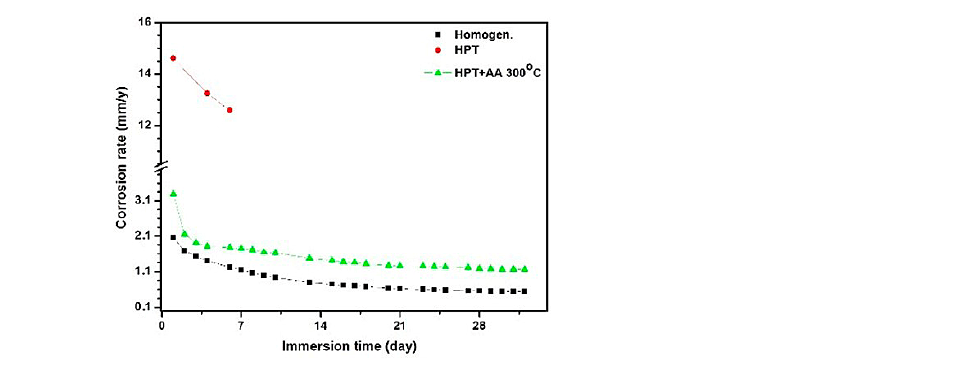
Figure 2. Corrosion rate of the Mg-1%Zn-0.2%Ca samples exposed in Ringer’s solution for a period of 1 to 32 days. Table 1. Mass loss and corrosion rate of the Mg-1Zn-0.2Ca alloy during corrosion tests in Ringer’s